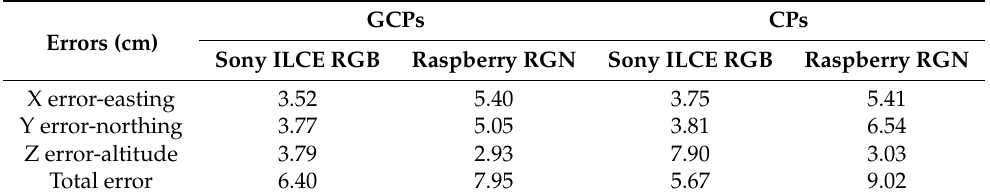
Table 2. RMSE value of the ground control points (GCPs) and check points (CPs). GCPs CPs Errors (cm) Sony ILCE RGB Raspberry RGN Sony ILCE RGB Raspberry RGN X error-easting 3.52 Y error-northing Z error-altitude